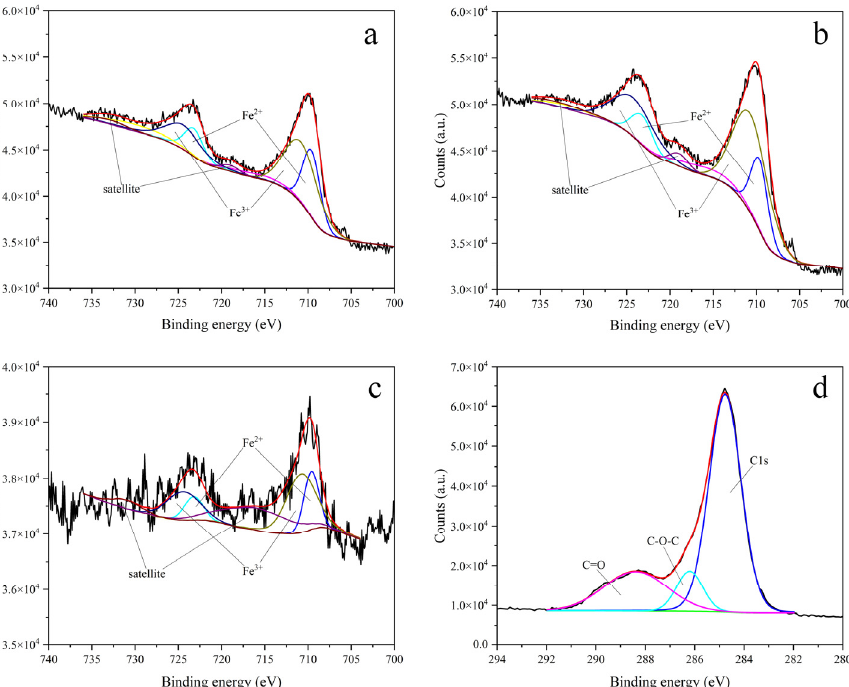
Figure 8. Fine spectra of Fe on the surface of carbon steel electrodes in different environments. ( a ) Simulated concrete pore solution, ( b ) simulated concrete pore solution mixed with 3% NaCl, ( c ) corrosion inhibitor solution and C on the surface of carbon steel electrodes in different environ- ments. ( d ) Corrosion inhibitor solution.